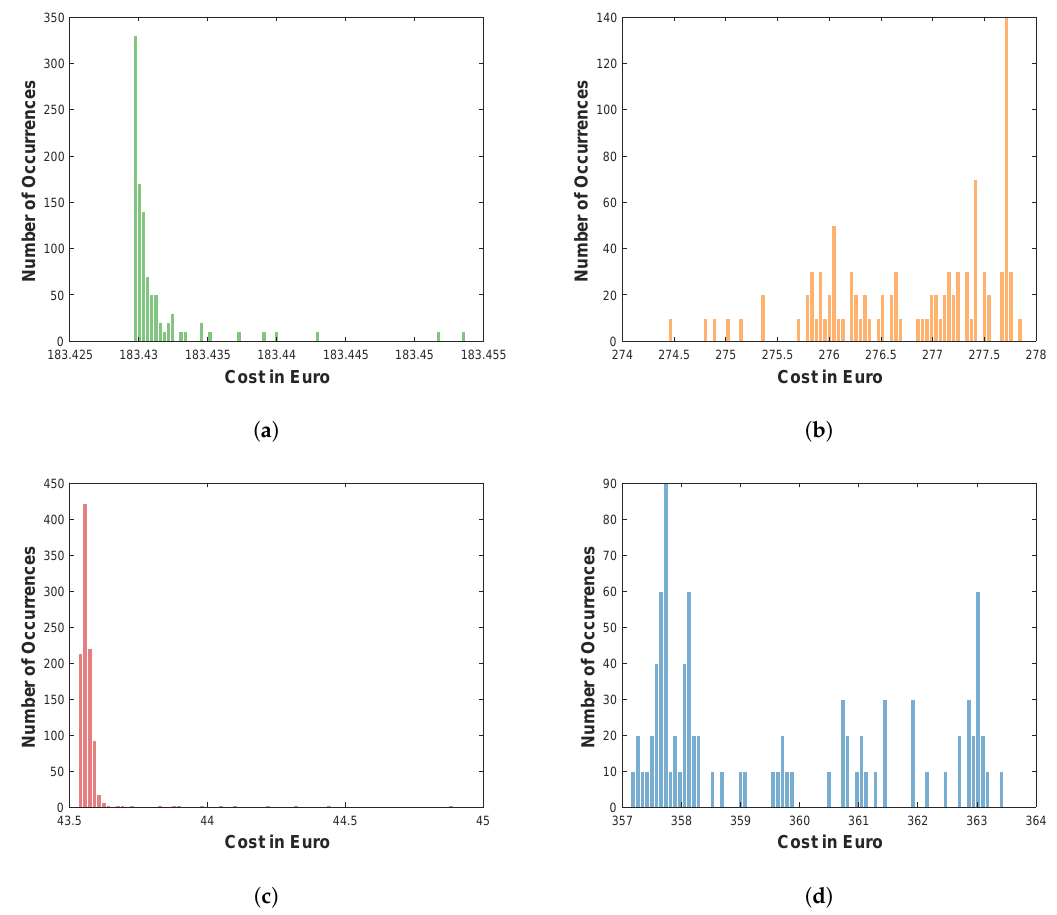
Figure 9. Histograms of the convergence of the total cost considering the four different tested cost functions. ( a ) Cubic cost function; ( b ) Quadratic cost function; ( c ) Exponential cost function; ( d ) Linear cost function.